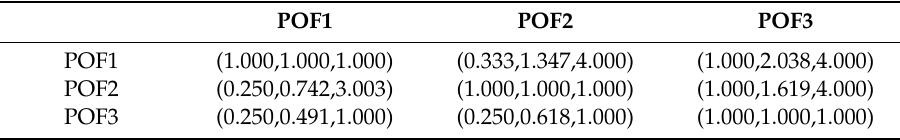
Table A7. Fuzzy pairwise comparison with respect to political criteria (POF).